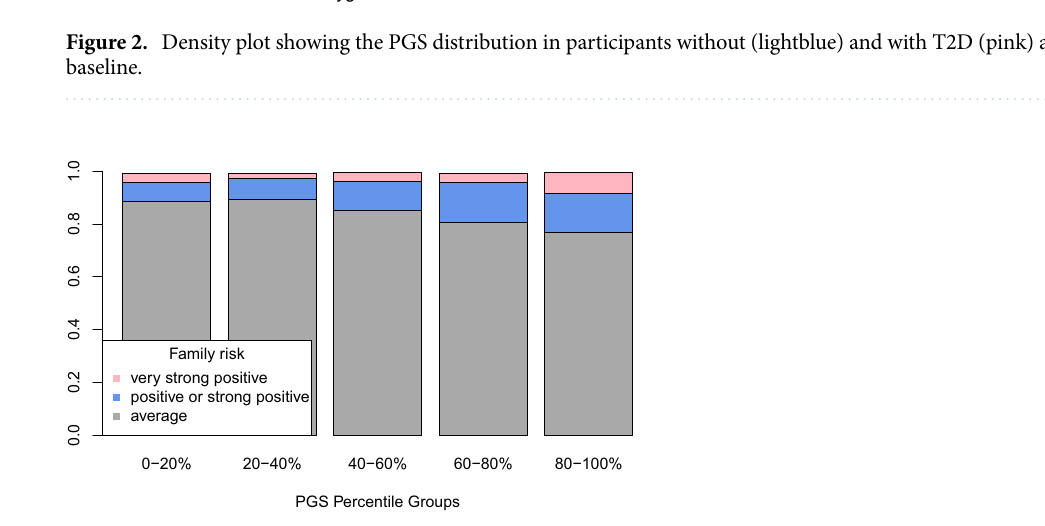
Figure 3. Relative amount of individuals in each FamRS category across the PGS percentile